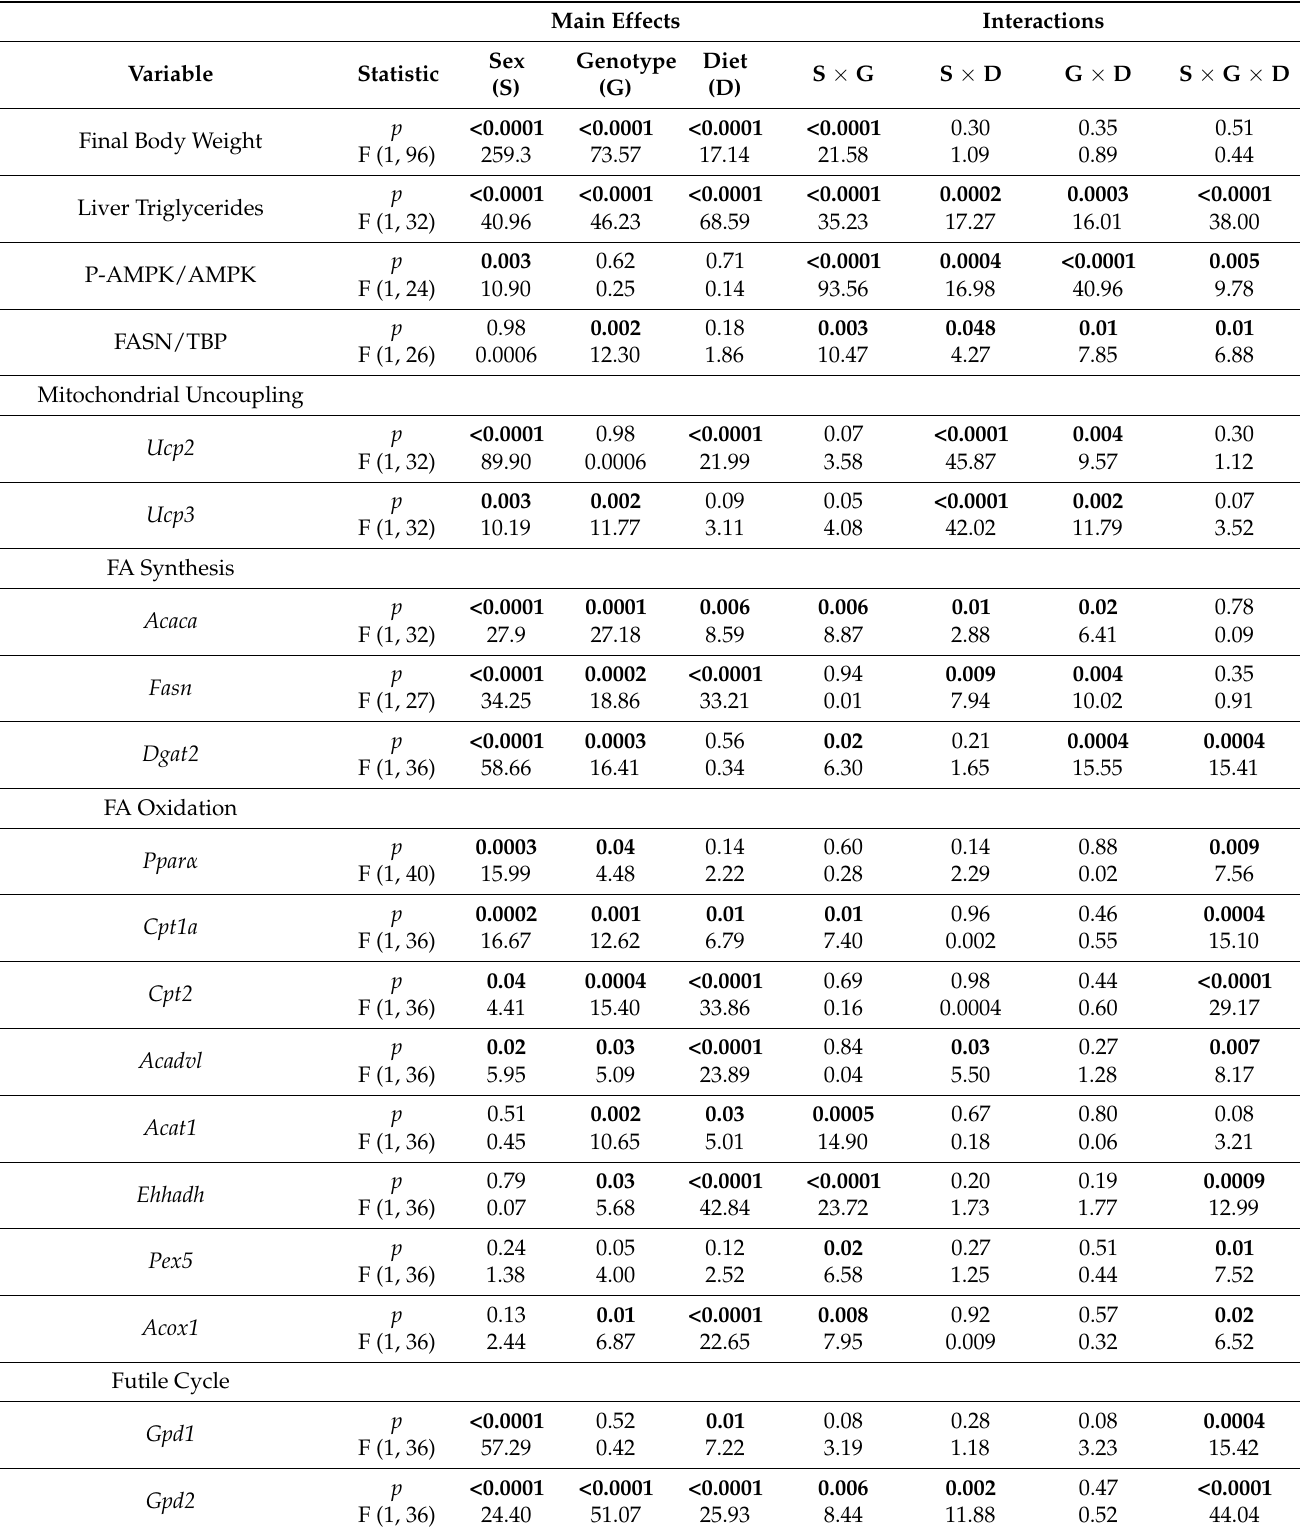
Table 1. Role of sex, genotype, and diet in livers of UCP1 KO